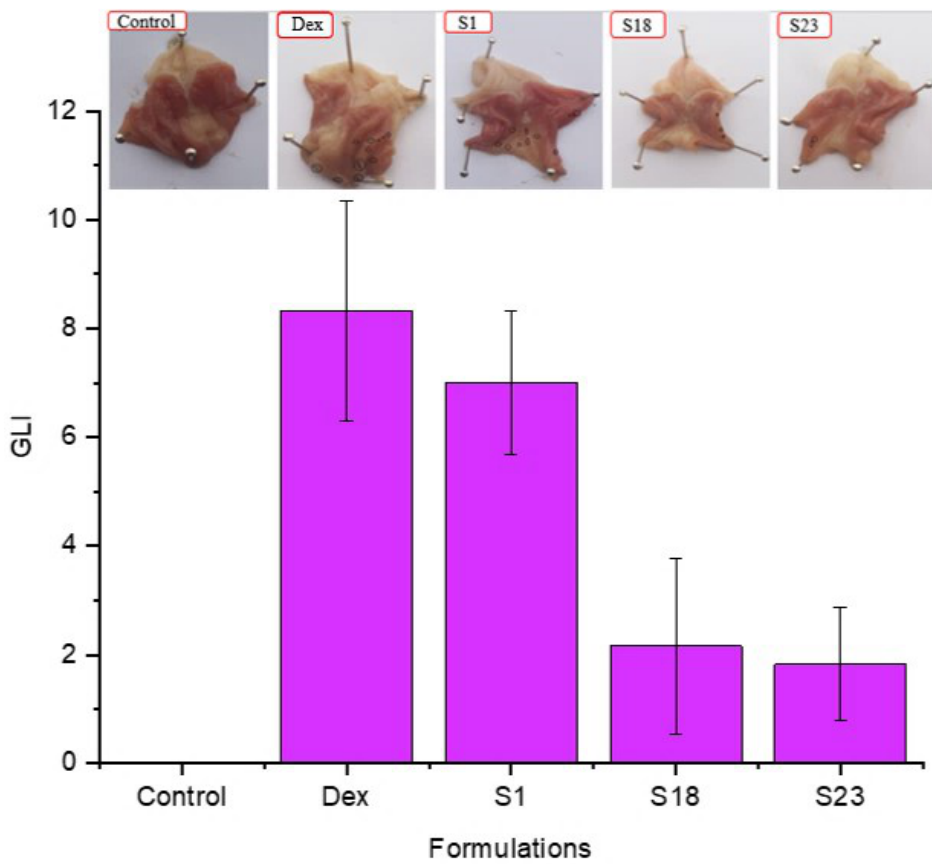
Figure 8. Stomach mucosa of rats and gastric lesions scores. The error bar designates the standard deviation (n =